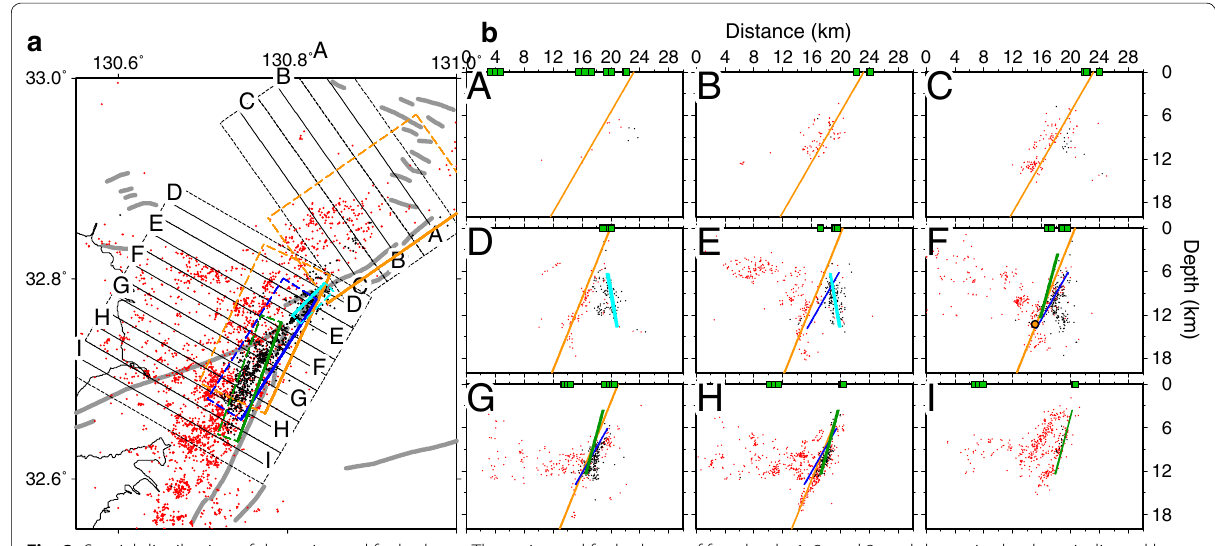
Fig. 2 Spatial distribution of the estimated fault planes. The estimated fault planes of foreshocks 1, 2, and 3, and the main shock are indicated by blue, light blue, green and orange lines, respectively, on a the map view and b the cross-sectional views. Circles show the hypocenters for the period from April 14, 2016 to June 11, 2016. Black and red denote the hypocenters before and after the main shock, respectively